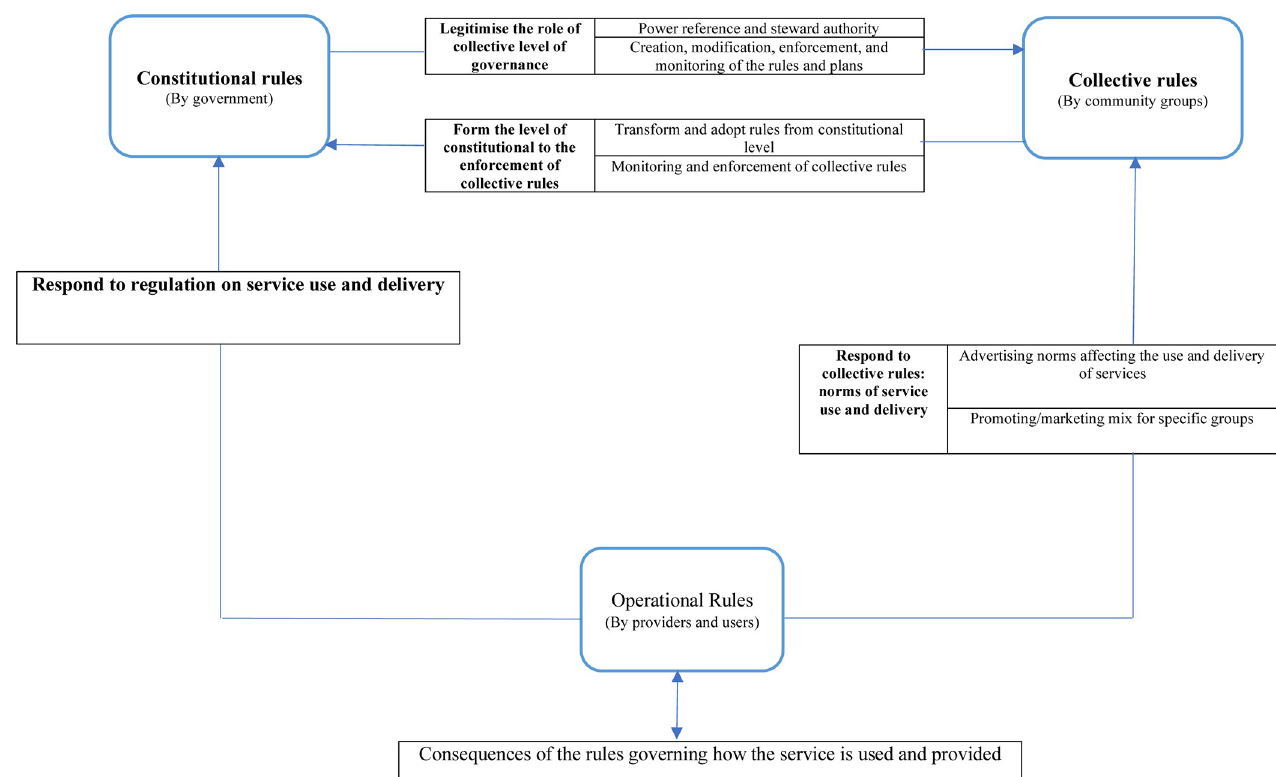
Fig 2. The framework of rules directed from Dental Benefits Act